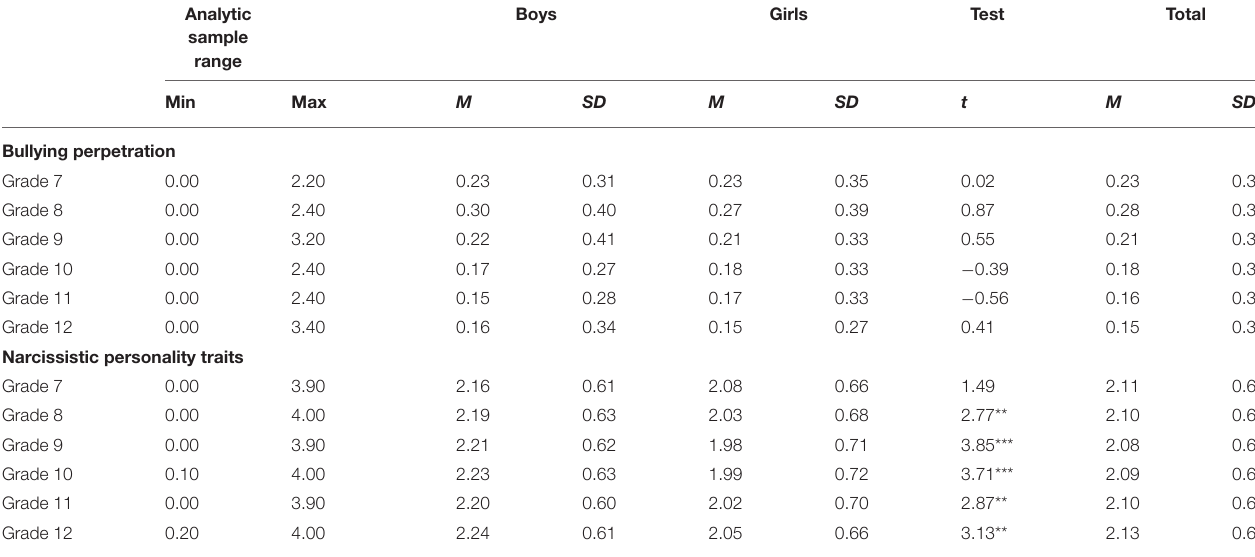
TABLE 1 | Descriptive statistics for joint trajectory variables. Analytic sample